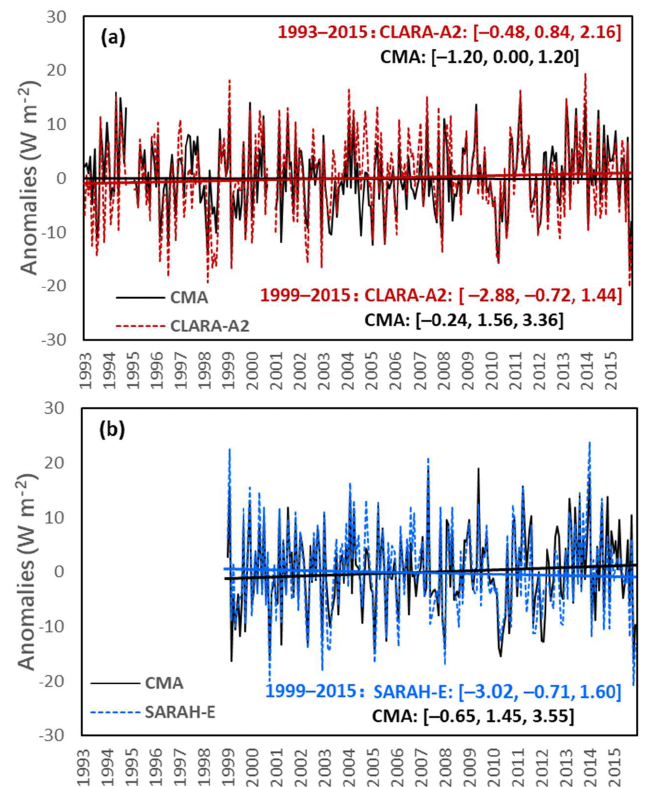
Figure 9. Comparisons of the trends in the monthly SSR anomalies between the collocated CLARA- A2 ( a , red lines)/SARAH-E ( b , blue lines) and CMA (black lines) datasets for the common periods. Values are the linear decadal trend slopes and the 95% confidence intervals (W m −2 decade −1 ).